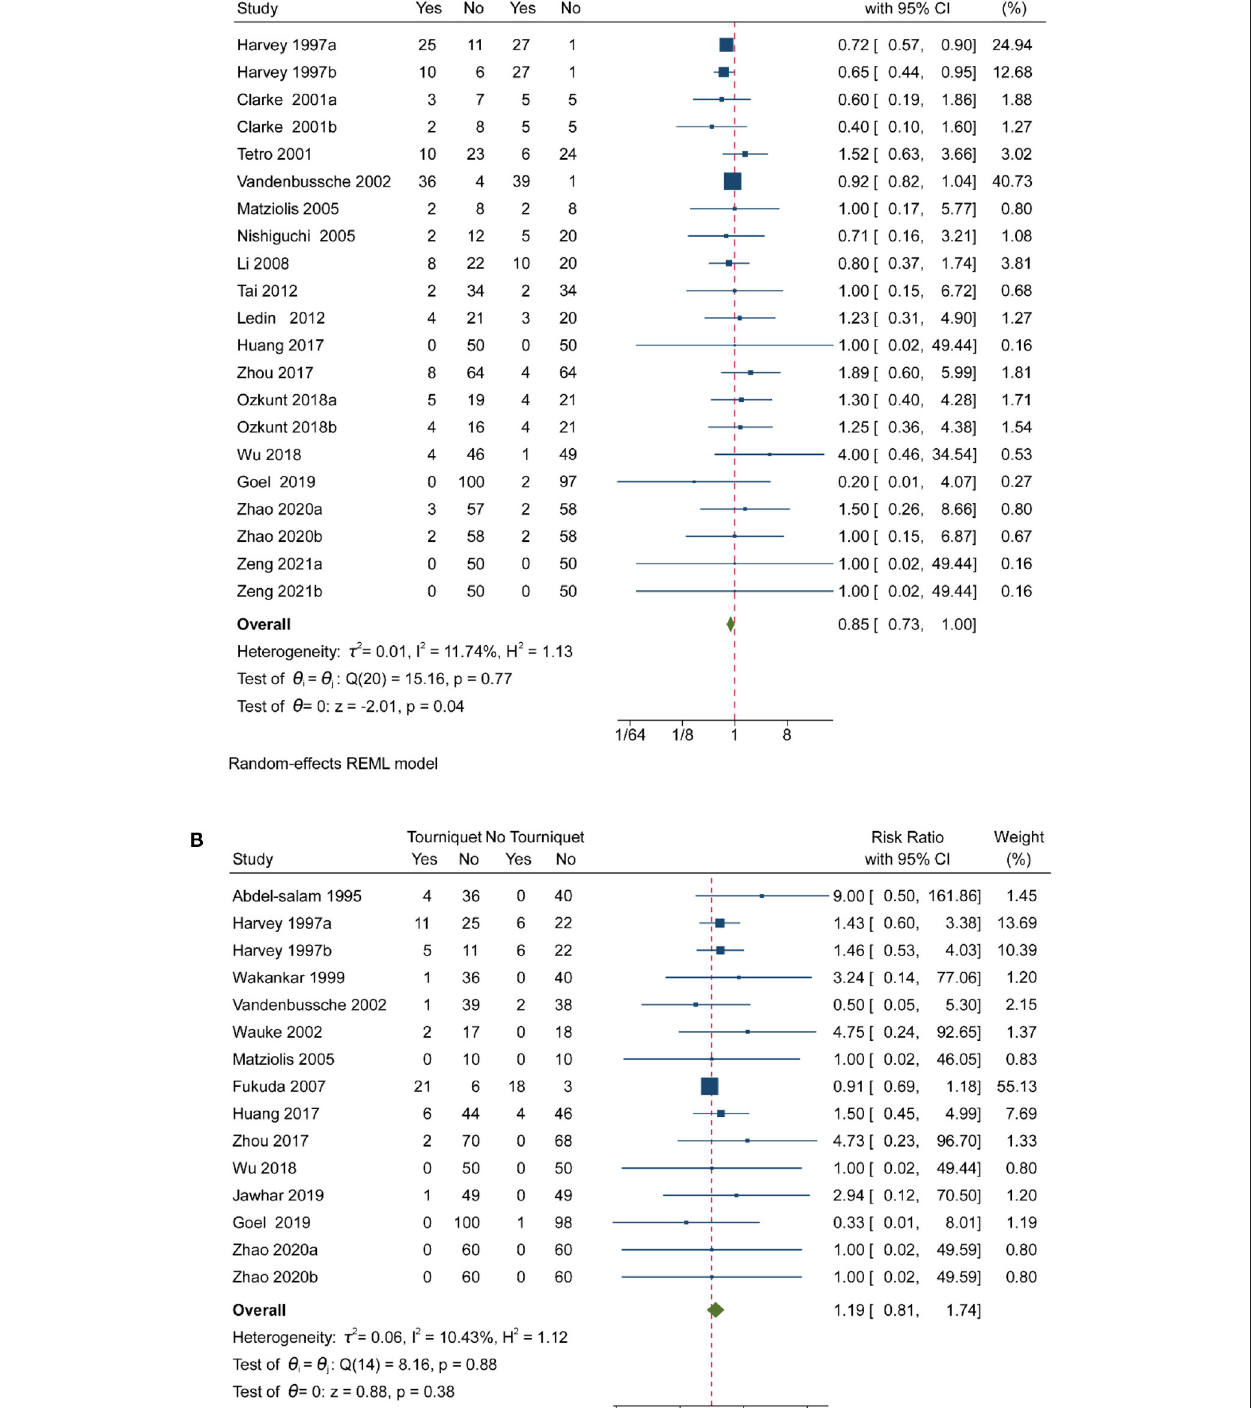
Frontiers in Public Health |